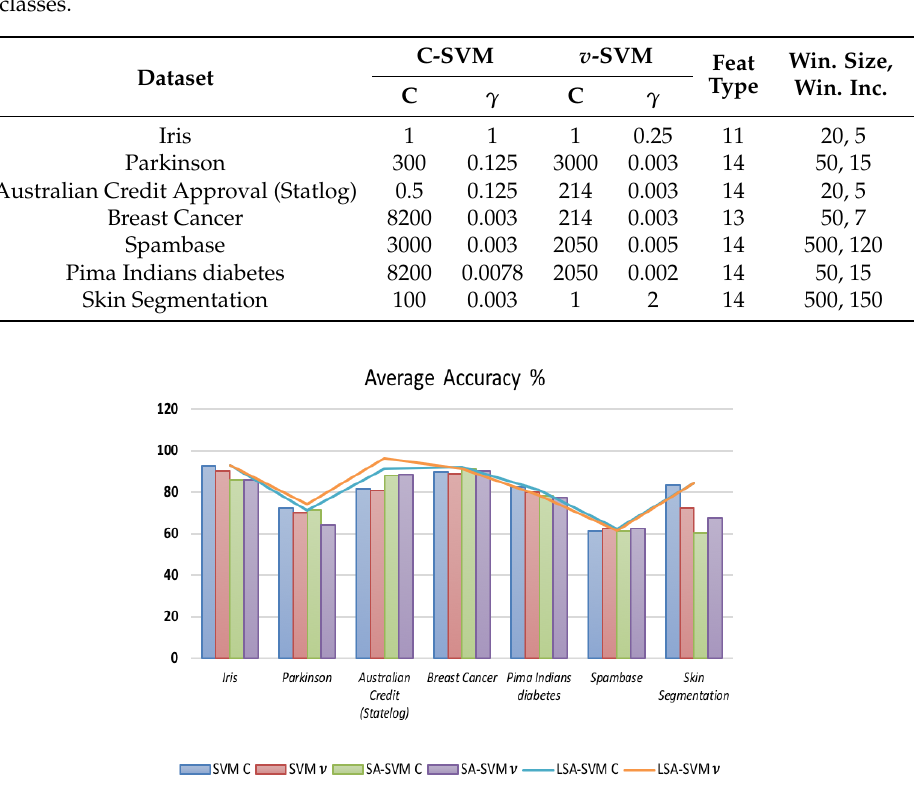
Figure 15. The accuracy of seven classifiers on different data using 5-fold cross validation for small and medium-size data and 3-fold cross validation for large size data for 2 classes.